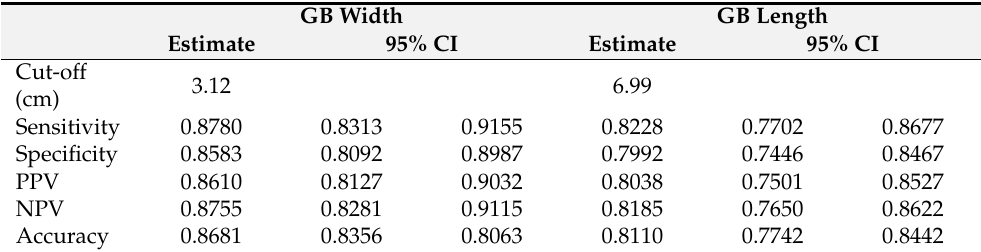
Table 2. Univariable logistic regression analysis of gallbladder (GB) width and length and acute cholecystitis.